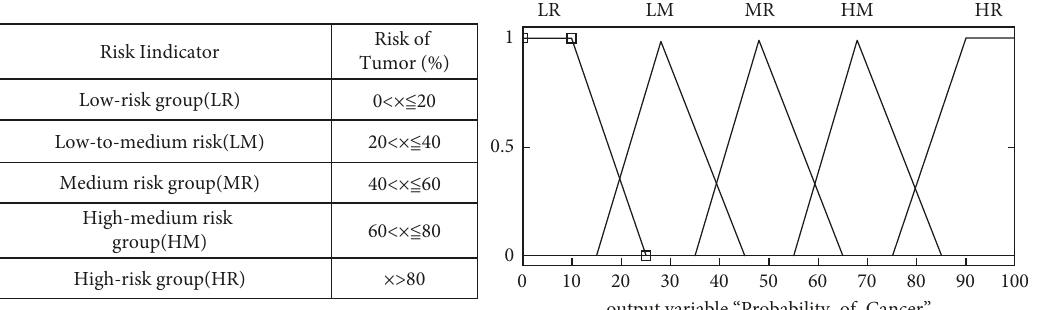
Figure 9: Risk of cancer.